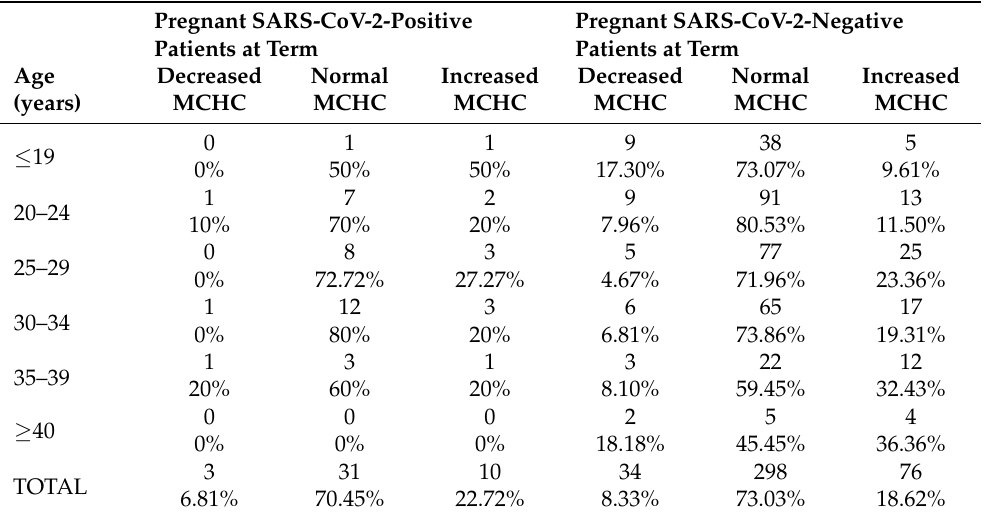
Table 12. Number and percentage of pregnant patients with normal, increased, and decreased values of MCHC by age group.